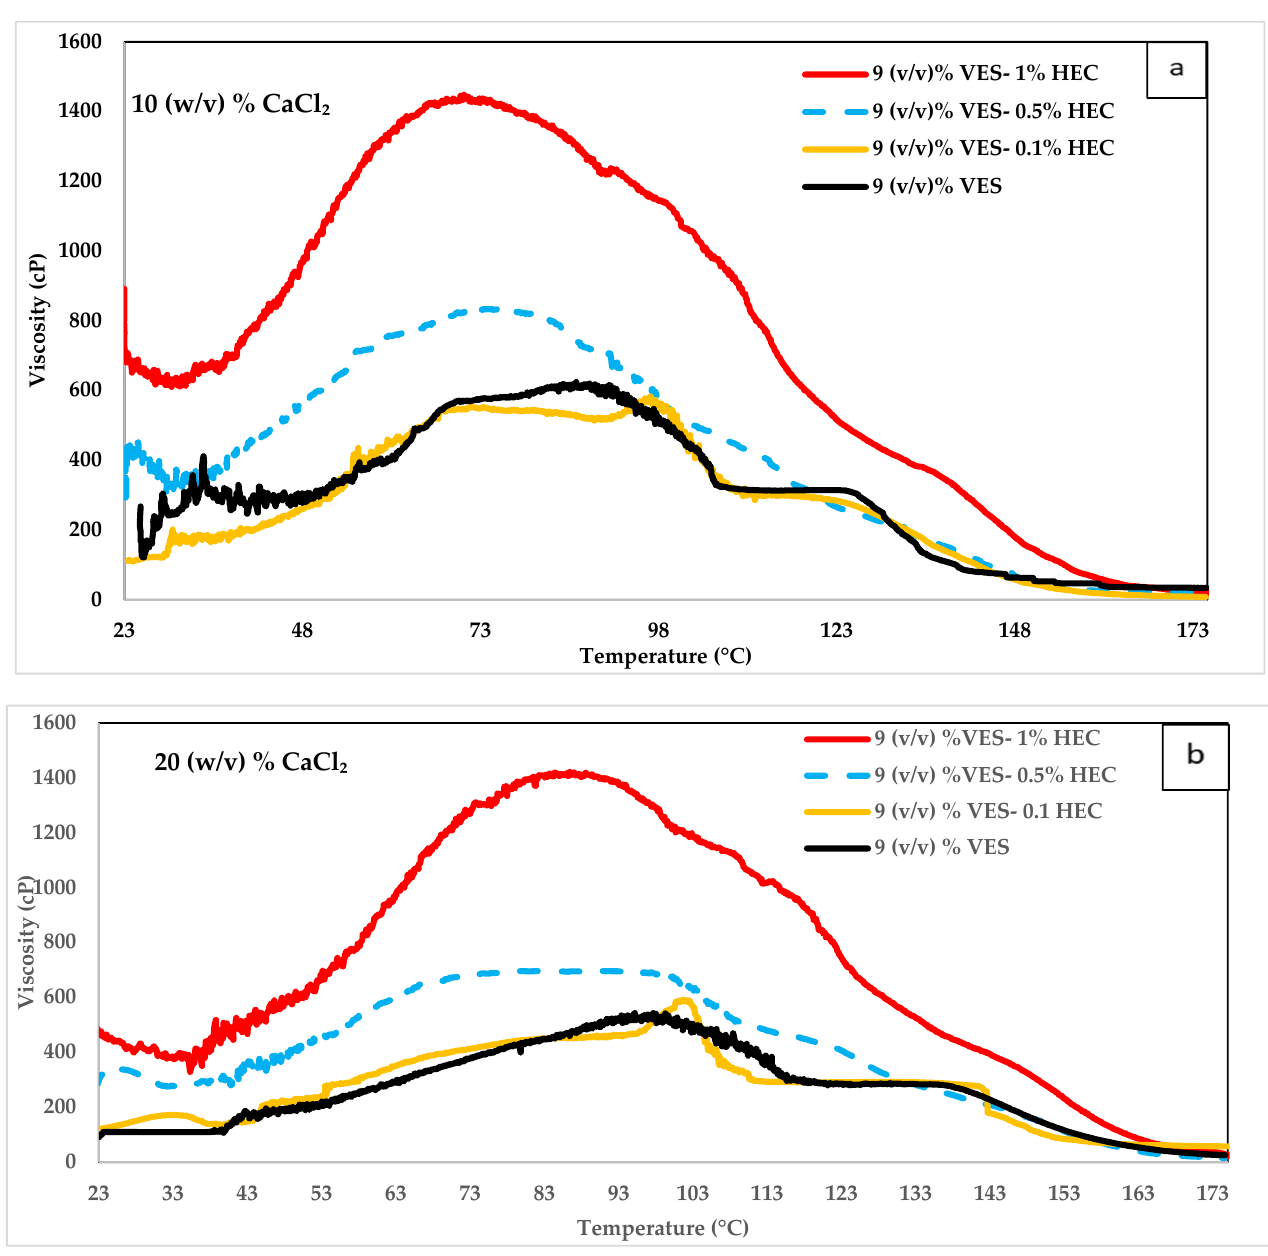
Figure 8. VES + HEC viscosity variation with respect to temperature at 10% ( a ) and 20% ( b ) CaCl 2 concentrations.